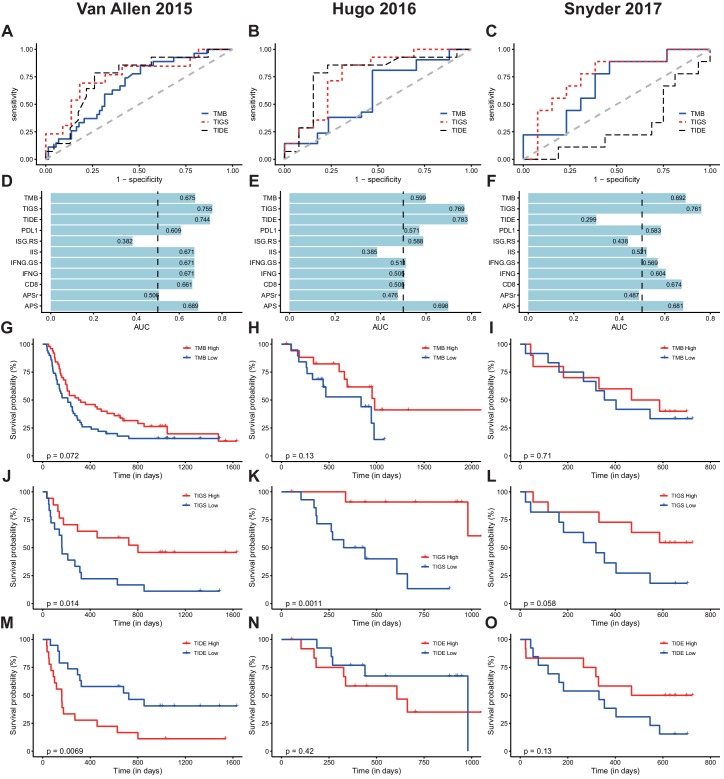
TIGS predicts clinical response to ICI immunotherapy.(A) ROC curves for the performance of TMB, TIDE and TIGS in predicting anti-CTLA4 Immunotherapy response in 35 melanoma patients (dataset from Van Allen et al., 2015). (B) ROC curves for the performance of TMB, TIDE and TIGS in predicting anti-PD-1 immunotherapy response in 27 melanoma patients (dataset from Hugo et al., 2016). (C) ROC curves for the performance of TMB, TIDE and TIGS in predicting anti-PD-L1 immunotherapy response in 22 urothelial cancer patients (dataset from Snyder et al., 2017). (D–F) AUC values of TMB, TIGS, TIDE, PDL1, immune infiltration score (IIS), interferon gamma gene expression signature (IFNG), CD8, APS and random genes as negative control for APS quantification (APSr) in the Van Allen et al. (2015) dataset (D), the Hugo et al. (2016) dataset (E) and the Snyder et al. (2017) dataset (F). The performance of a random predictor (AUC = 0.5) is represented by the dashed line. (G,J,M) Patients were grouped on the basis of TMB (G), TIGS (J) or TIDE (M) status. The Kaplan–Meier (KM) overall survival curves were compared between TMB-High and TMB-Low (100 patients), between TIGS-High vs TIGS-Low (35 patients) or between TIDE-High and TIDE-Low (37 patients) in the Van Allen et al. (2015) dataset. (H,K,N) Patients were grouped on the basis of TMB (H), TIGS (K) or TIDE (N) status. The KM overall survival curves were compared between TMB-High and TMB-Low (37 patients), between TIGS-High and TIGS-Low (26 patients) or between TIDE-High and TIDE-Low (26 patients) in the Hugo et al. (2016) dataset. (I,L,O) Patients were grouped on the basis of TMB (I), TIGS (L) or TIDE (O) status. The KM overall survival curves were compared between TMB-High and TMB-Low (22 patients), TIGS-High and TIGS-Low (22 patients) or TIDE-High and TIDE-Low (25 patients) in the Snyder et al. (2017) dataset.10.7554/eLife.49020.021Figure 5—source data 1.List of genes in the lists used for CD8, IFNG, ISG.RS and IFNG.GS signature calculation.